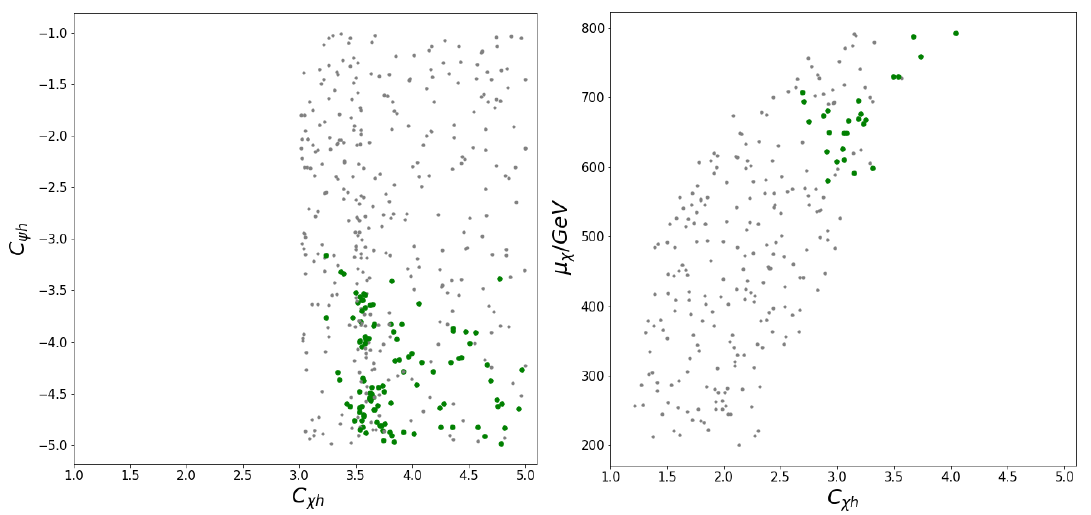
Figure 9 . As figure 8 but for tan β = 3 and n χ = n ψ = 30